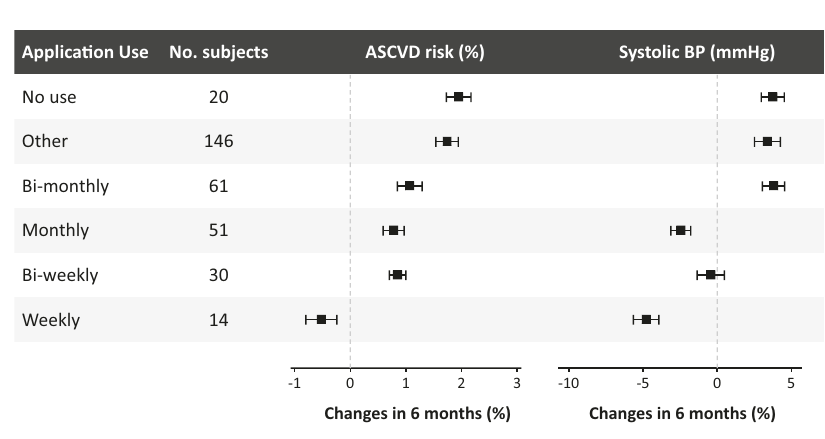
Fig. 2 Subgroup analysis. Subgroup analysis results according to application use during the study period.